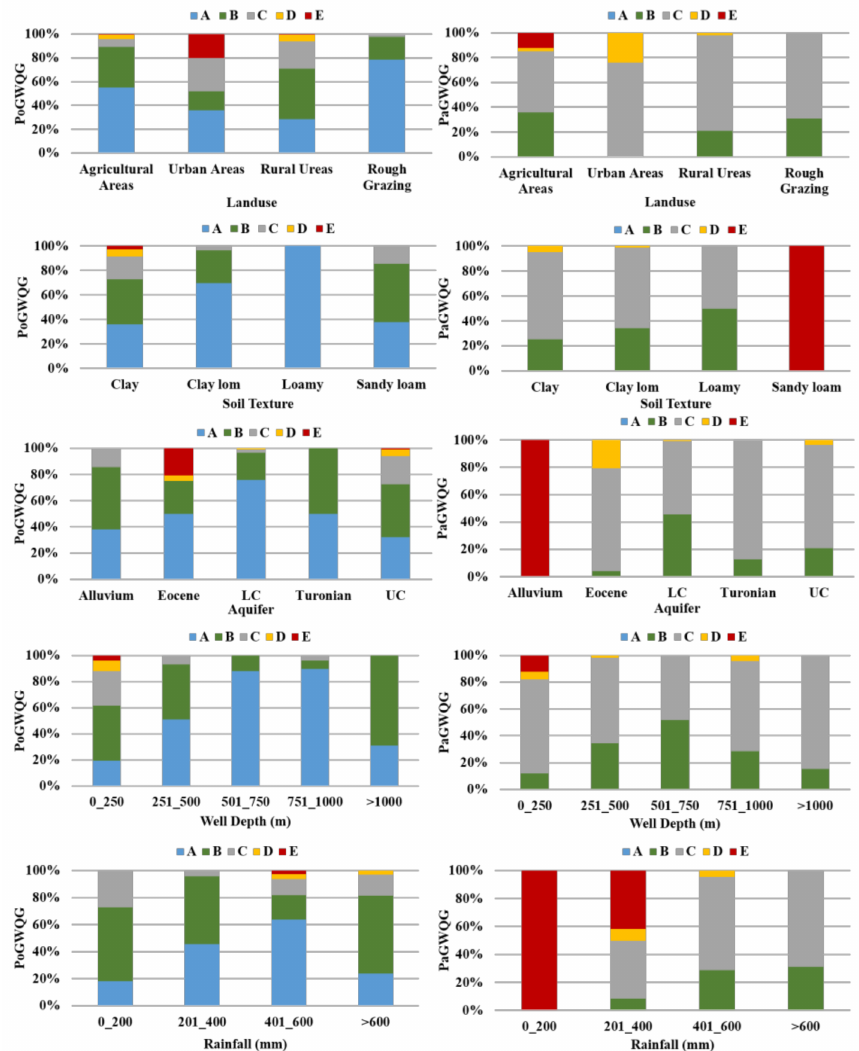
Figure 9. Factors affecting PoGWQI and PaGWQI in the West